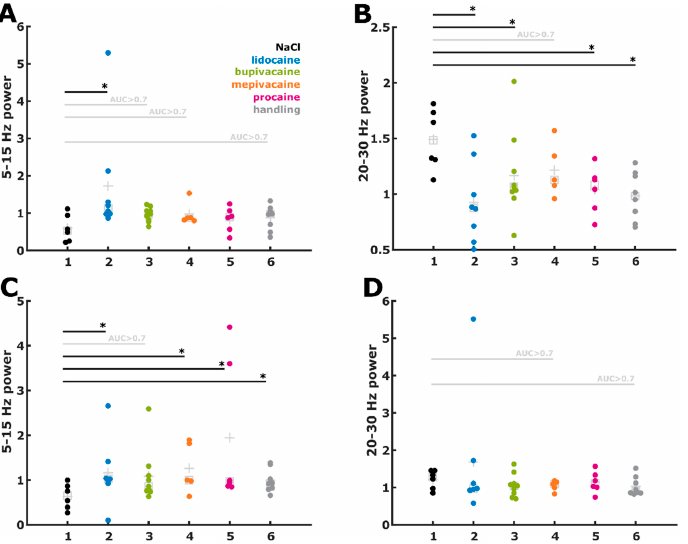
Figure 5. Comparison of ‘early‘ and ‘late‘ reactions following skin incision ( A , B ) and spermatic cord dissection ( C , D ), compared with the NaCl group. ( A ) For skin incisions, a significant (*) or possibly relevant (AUC > 0.7) effect was observed for the early response in all groups, except for the procaine group. The 5–15 Hz power decreased by a smaller amount as a reaction to the stimulus when compared with the change in the NaCl group.( B ) Regarding the late response, all groups showed a weaker activation of 20–30 Hz power as a result of the stimulation compared with that of the NaCl group. ( C ) As an early reaction following spermatic cord dissection, all groups exhibited a weaker 5–15 Hz response than the NaCl group. ( D ) Significant differences in the late 20–30 Hz power responses were not observed after spermatic cord dissection.